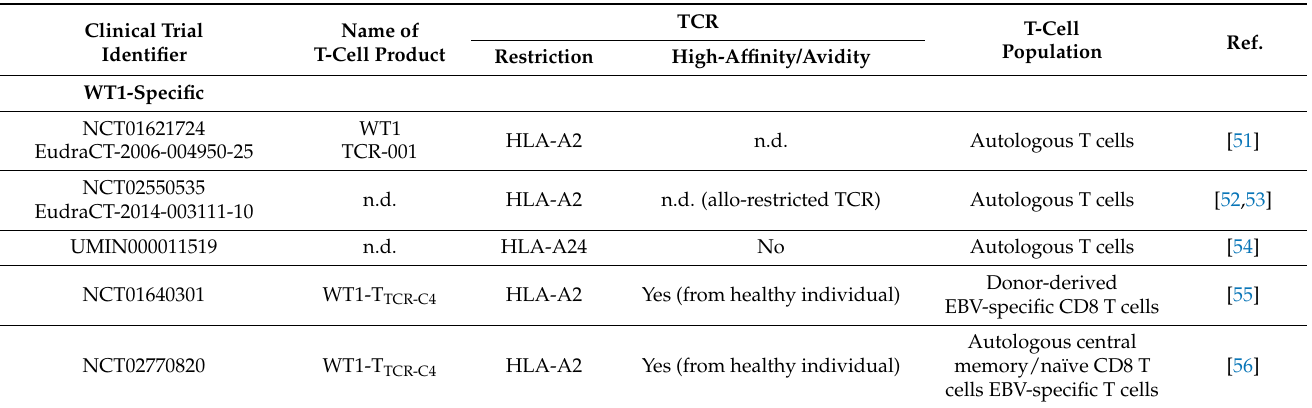
Table 2. Characteristics of T-cell